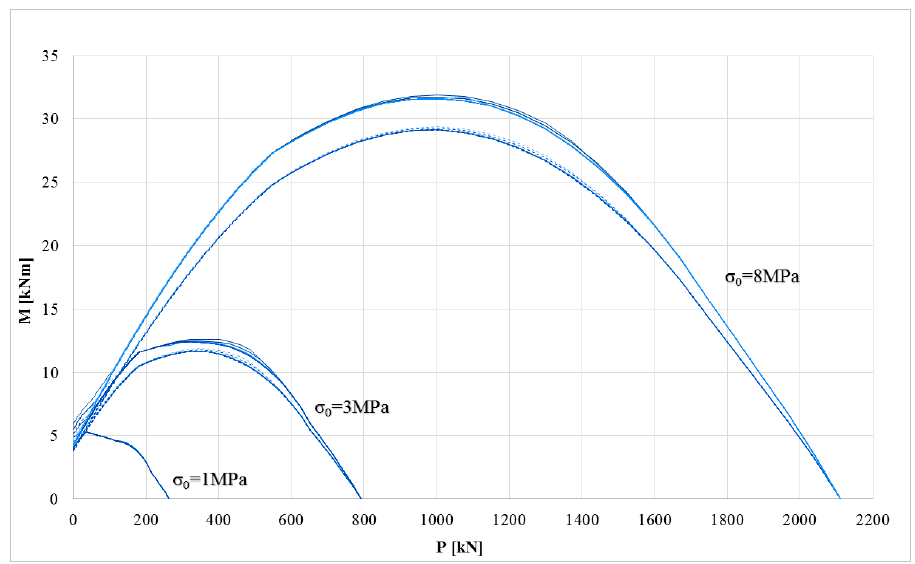
Figure 4. P-M domains of the strengthening system with natural fiber: bi-linear model (dotted line), tri-linear model (solid line).